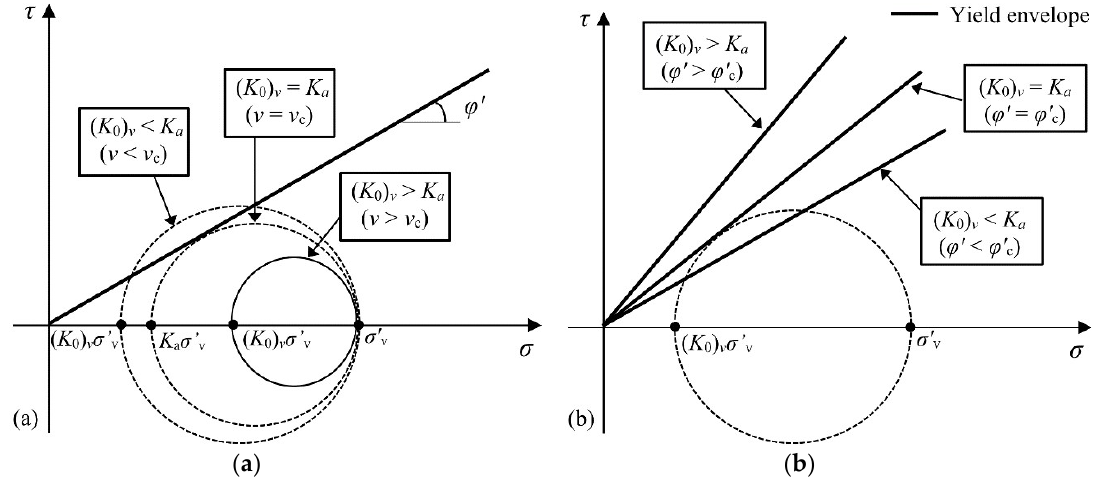
Figure 1. Stress states in backfills along the vertical centerline (VCL) of the opening illustrated by Mohr–Coulomb planes, with constant ( a ) internal friction angle ϕ’ and ( b ) Poisson’s ratio ν. The dotted line circle indicates an active state while the solid line circle indicates an at-rest state.